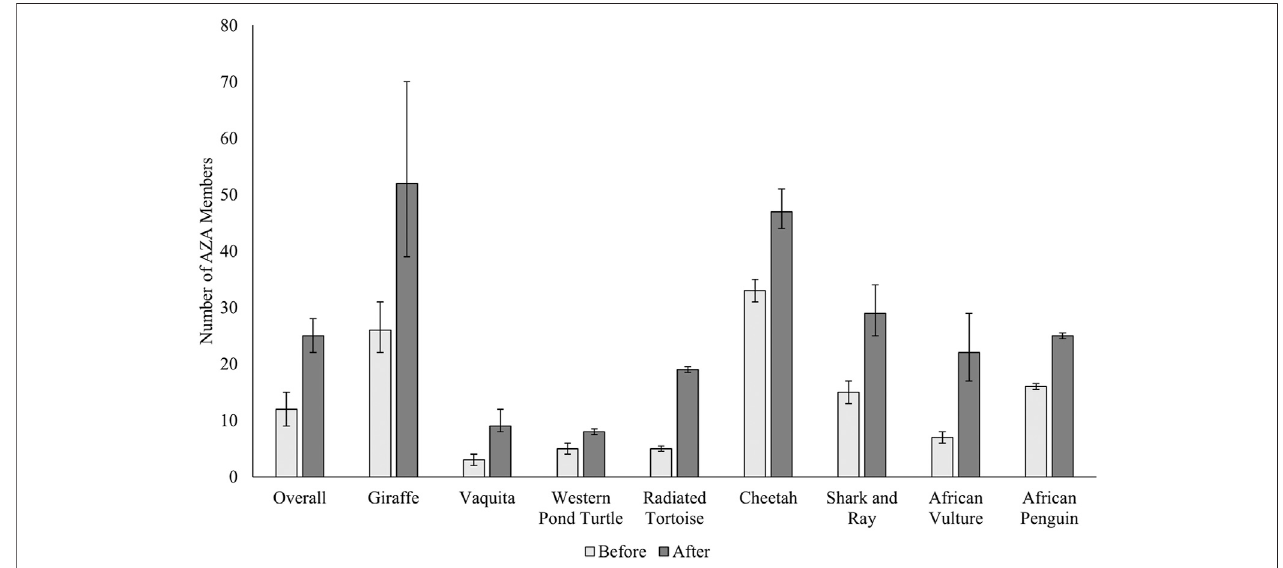
FIGURE 2 | Evaluation of the effect of SAFE project implementation on number of AZA member facilities participating in in situ conservation projects for individual species programs. Data is expressed as model generated means ± SEM. Variation in SEM is indicative of variable effect of SAFE programs and variation between different years. Overall effect and each species individually showed signi fi cantly more member engagement following SAFE program initiation.